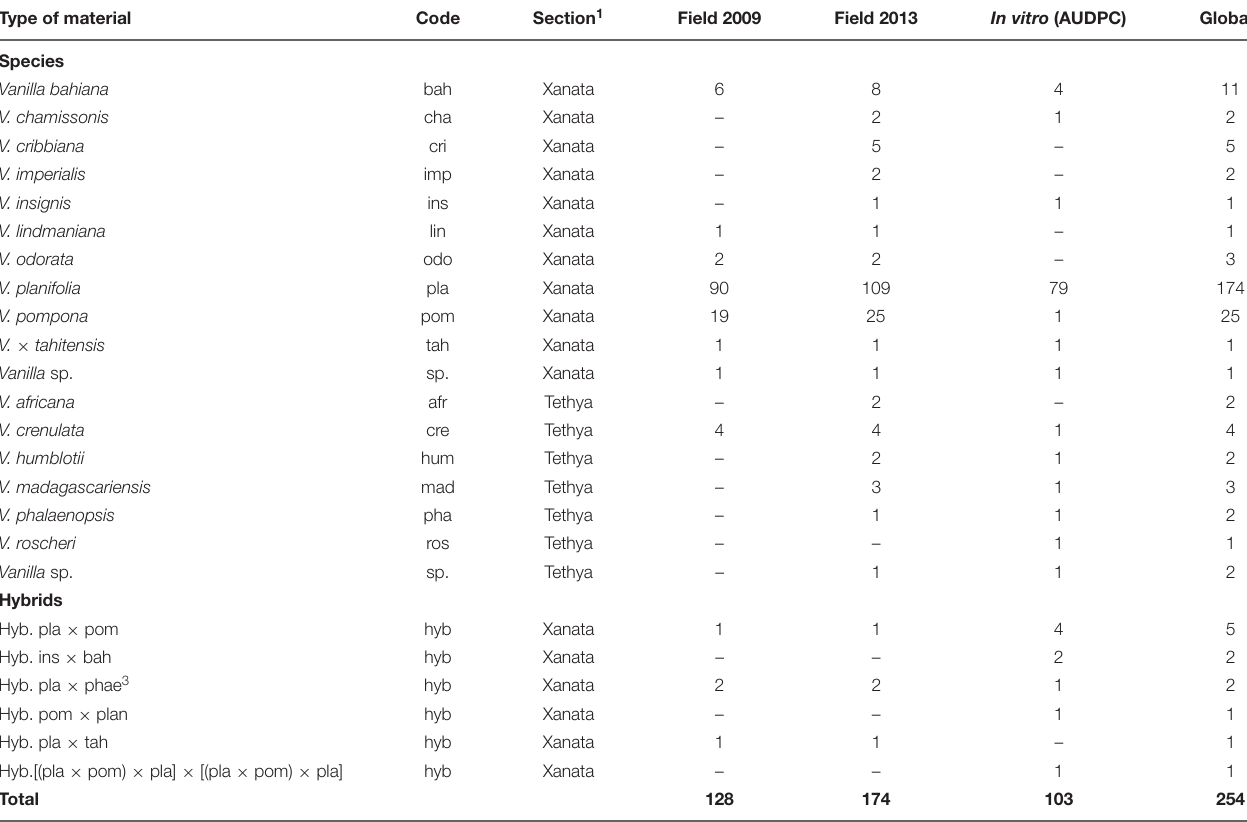
TABLE 1 | Number of Vanilla accessions evaluated for RSR resistance in the field in 2009 (RSR index) and 2013 (RSR level), and by in vitro inoculation test